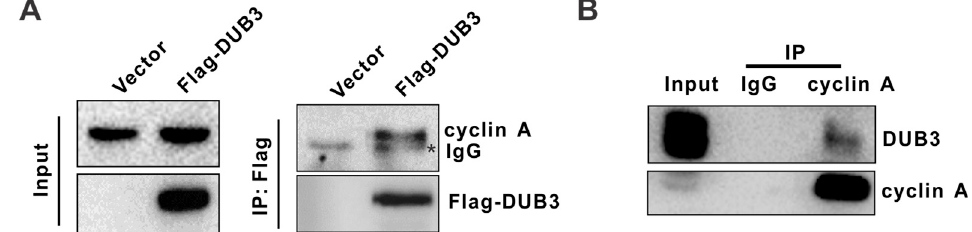
Figure 3. DUB3 interacts with cyclin A. ( A ) A549 cells were transfected with Flag-DUB3 plasmid or the control plasmid. Total cell lysates were subjected to immunoprecipitation with anti-Flag antibodies. The immunoprecipitates were then probed with anti-Flag or anti-cyclin A antibodies. (* IgG) ( B ) A549 cell lysates were subjected to immunoprecipitation with control IgG or anti-cyclin A antibodies. The immunoprecipitates were then probed with anti-DUB3 or anti-cyclin A